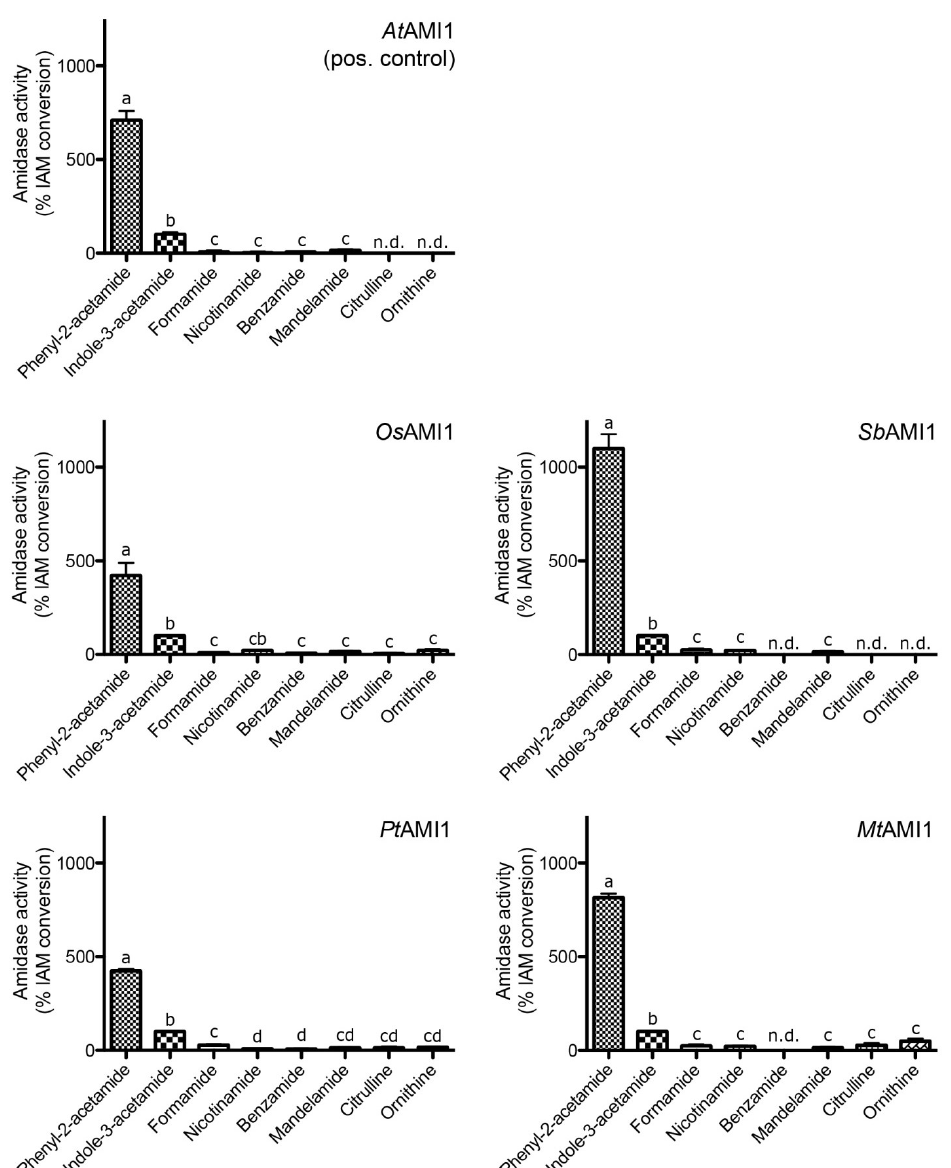
Figure 5. Analysis of the relative substrate conversion of recombinant